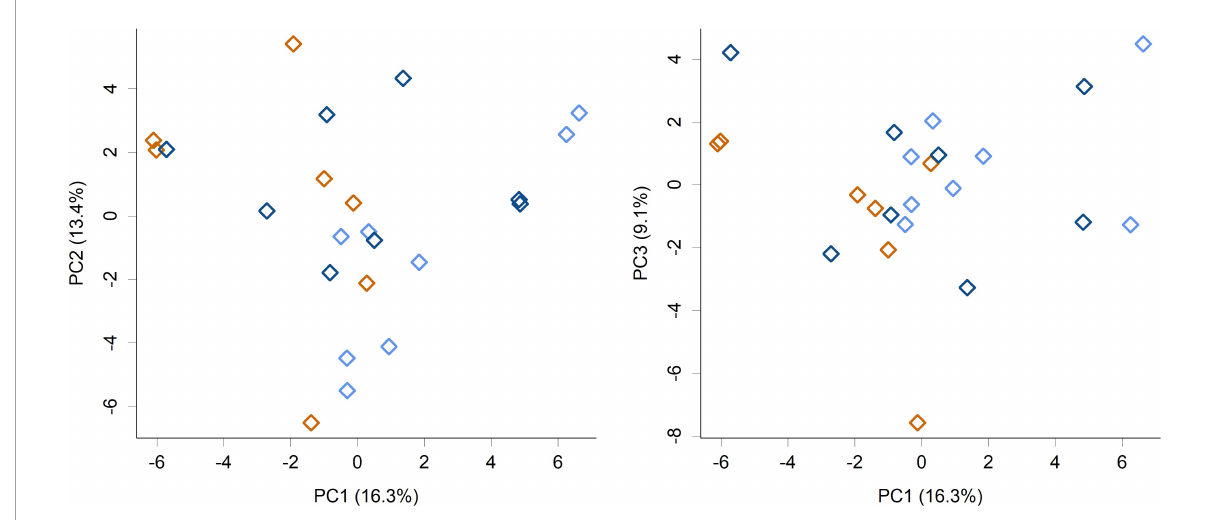
FIGURE3 PCA scores plot of the piglet fecal microbiome community composition at the genus level (PC1 vs. PC2 and PC1 vs. PC3 shown). Colors indicate groups; Control (orange), HN001 Low (light blue), HN001 High (dark blue). Permutation MANOVA P = 0.07.